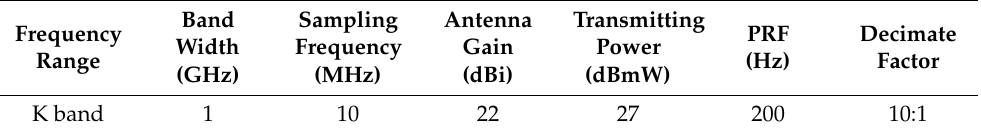
Figure 6. Experimental descriptions. The Hukun-Wuguang bridge is on the south of the southern Changsha railway station. The five longer cables on the north-east side are measured. Table 2. Parameters of simulation and the K band interferometric radar.